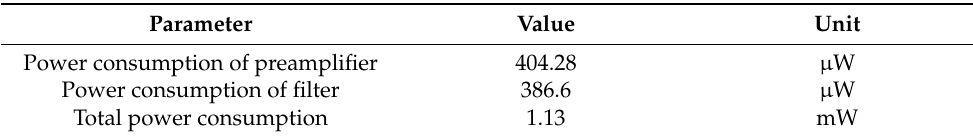
Table 21. Power consumption of the sensor interface circuits. Parameter